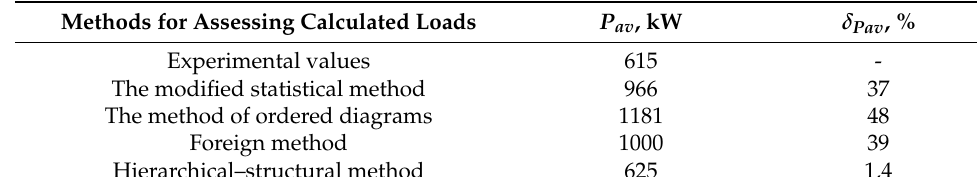
Table 17. Errors in determining the average value of power, P av , with various methods using a VFD relative to the hierarchical–structural method according to the truncated normal law.